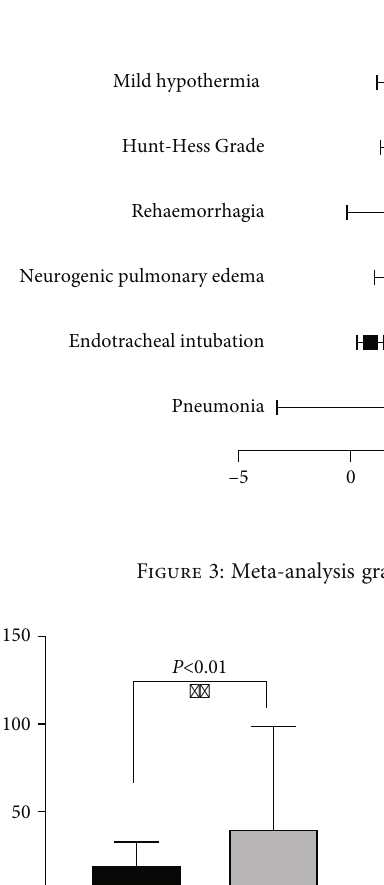
Figure 2: ICU stay and mechanical ventilation duration of aSAH patients in the GOS 1 – 3 and GOS 4 – 5 groups.